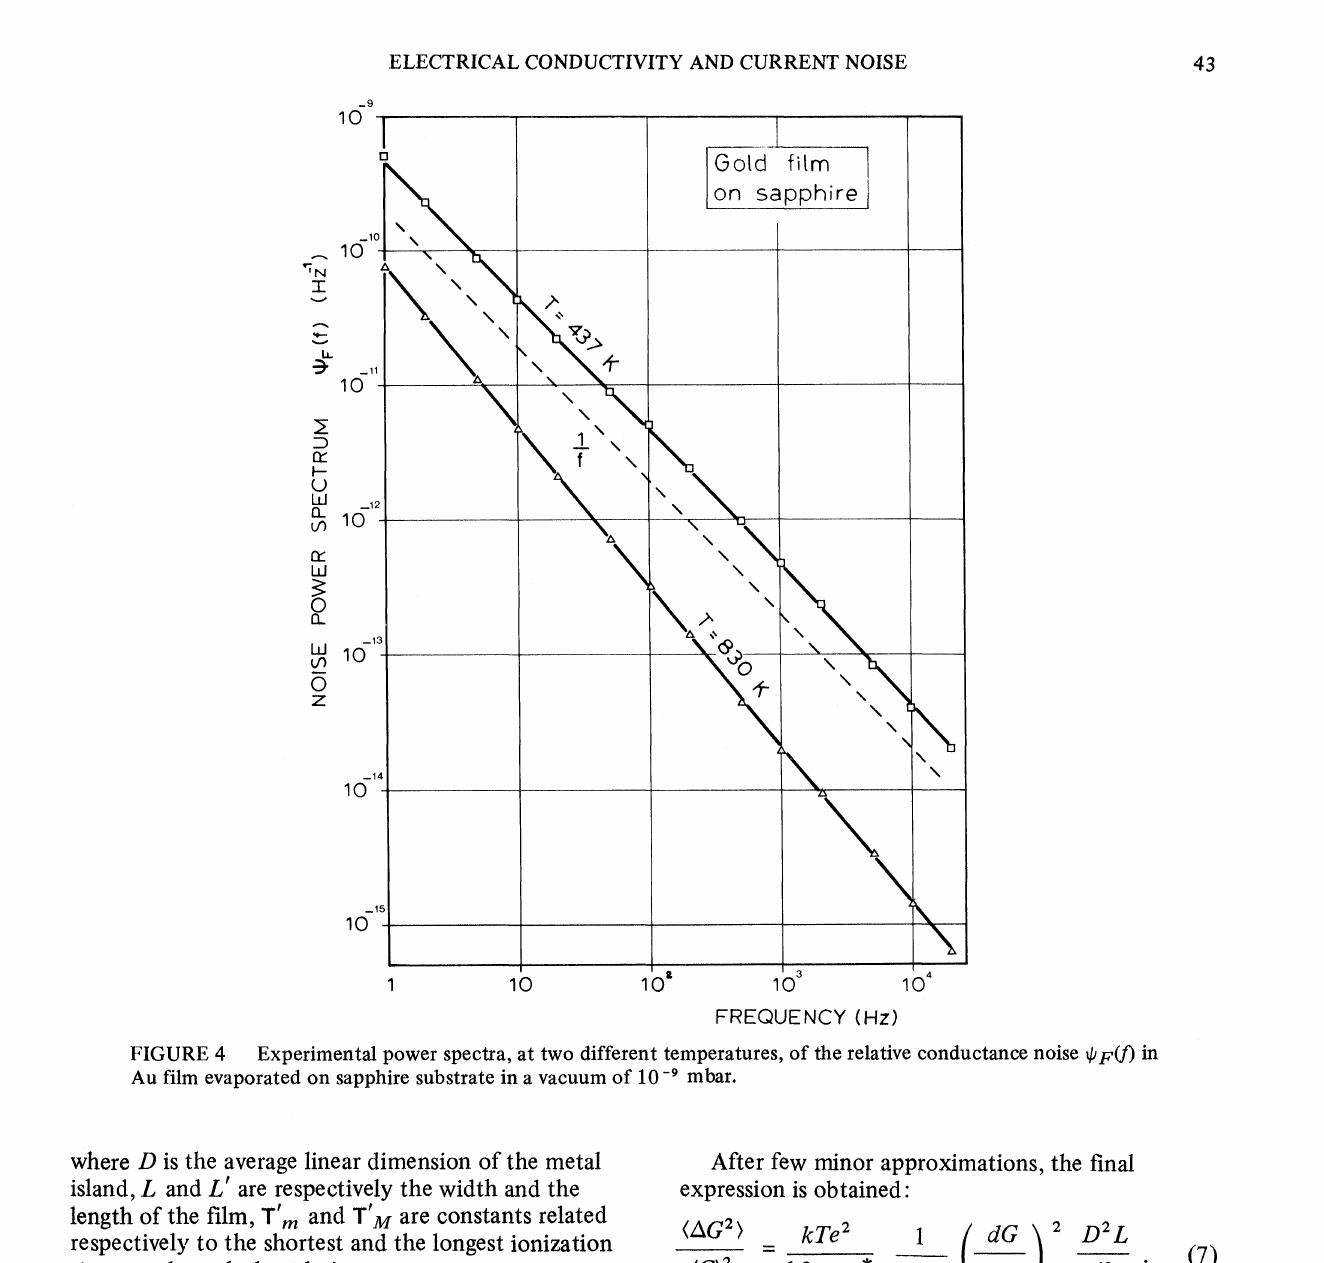
Experimental power spectra, at two different temperatures, of the relative conductance noise F00 in Au film evaporated on sapphire substrate in a vacuum of 10-9